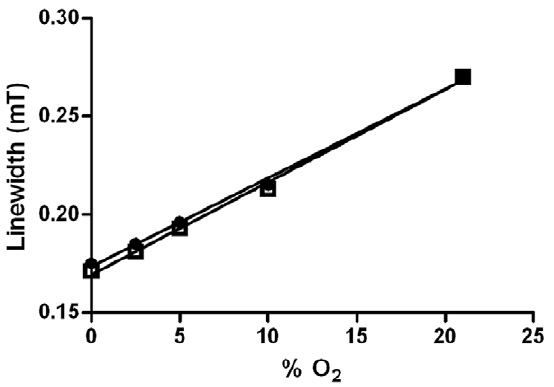
N Figure 2. Calibration of 15 N-PDT in function of %O 2 . Linear ) does not differ from calibration of 15 N- regression of nitroxide alone ( PDT with cytodex 1 beads ( % ).